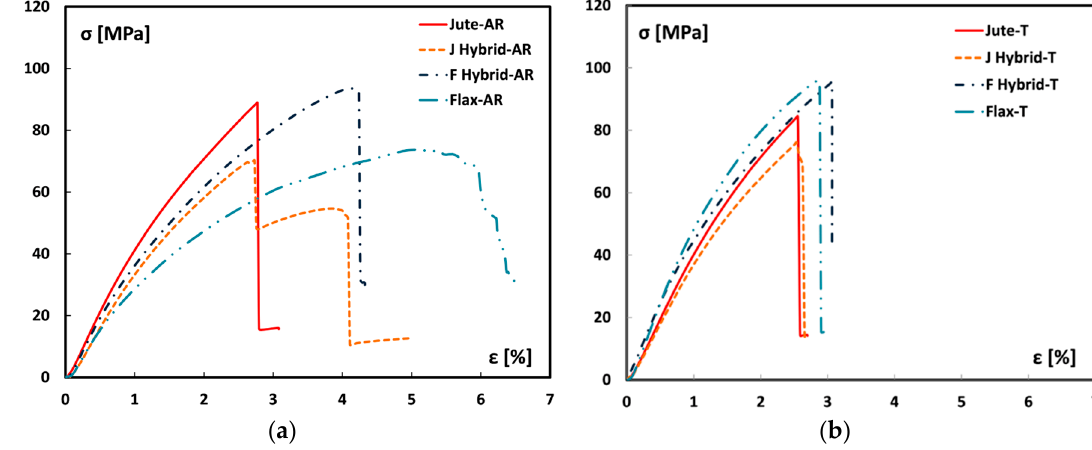
Figure 5. Typical stress vs. strain flexural curves of ( a ) untreated and ( b ) treated laminates.